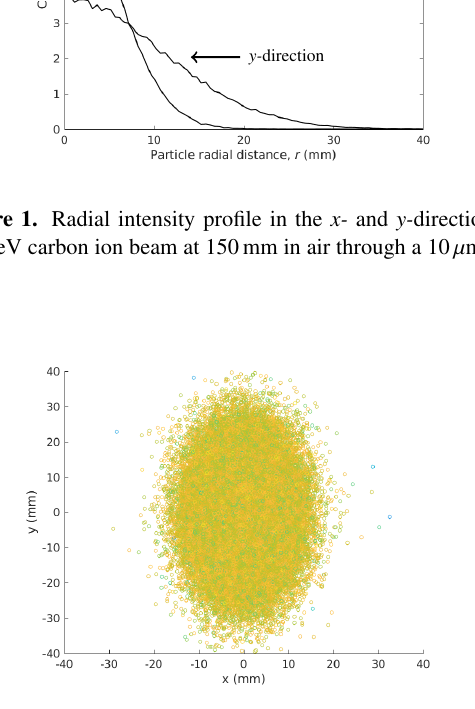
Figure 2. Two-dimensional beam profile for 70MeV carbon ion beam at z = 150mm beyond a 10 µ m Mylar